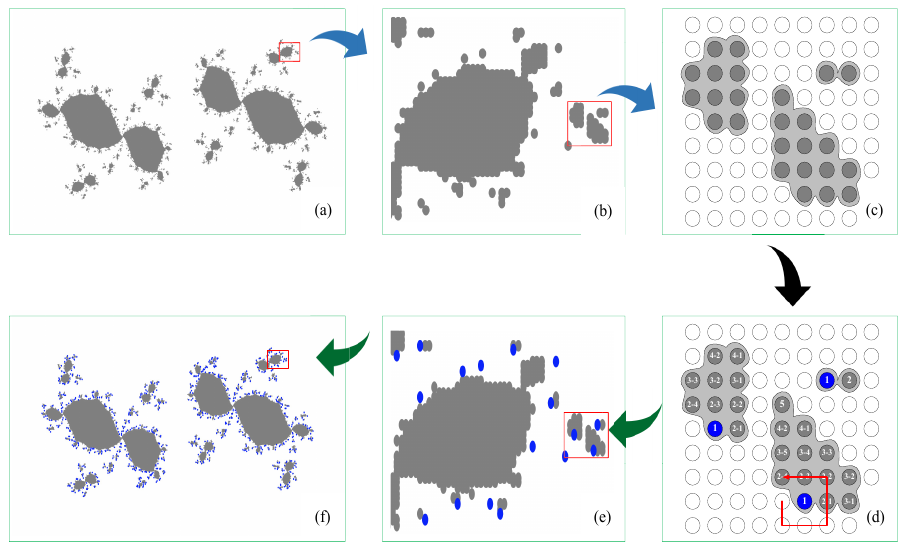
Figure 1. The flowchart of the proposed algorithm in which ( a , b ): corresponding to the steps (I), (II). ( c , d ): corresponding to the steps (III), (IV). ( e , f ): corresponding to the step